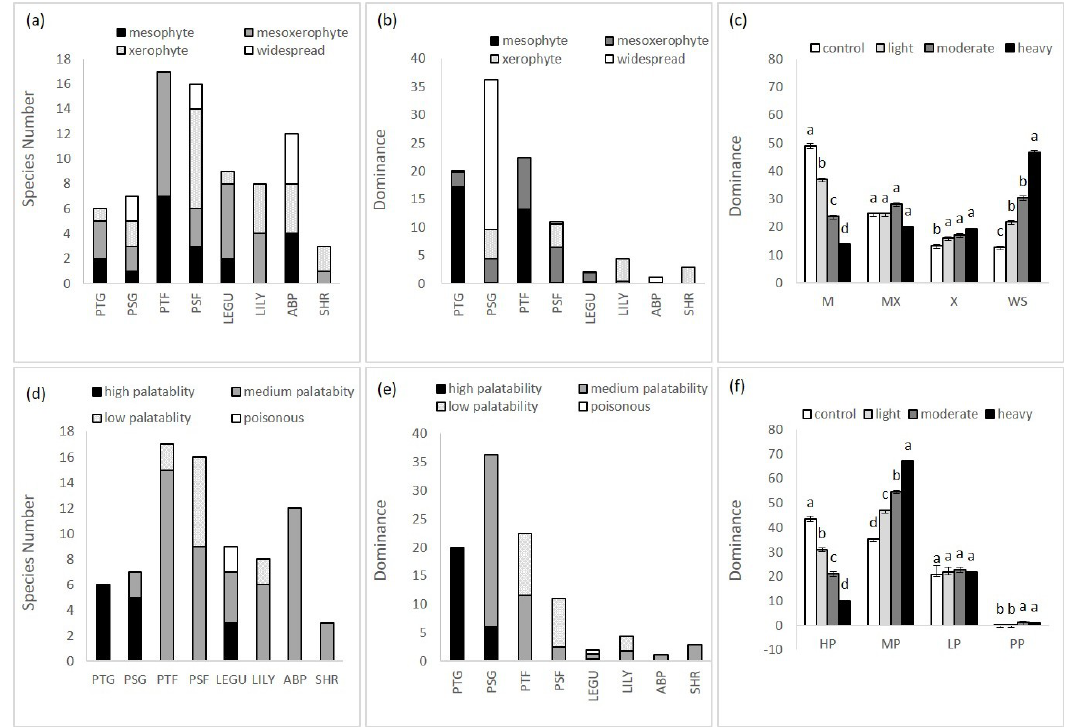
Figure 5. Change of water ecotypes and palatability of species in different plant functional